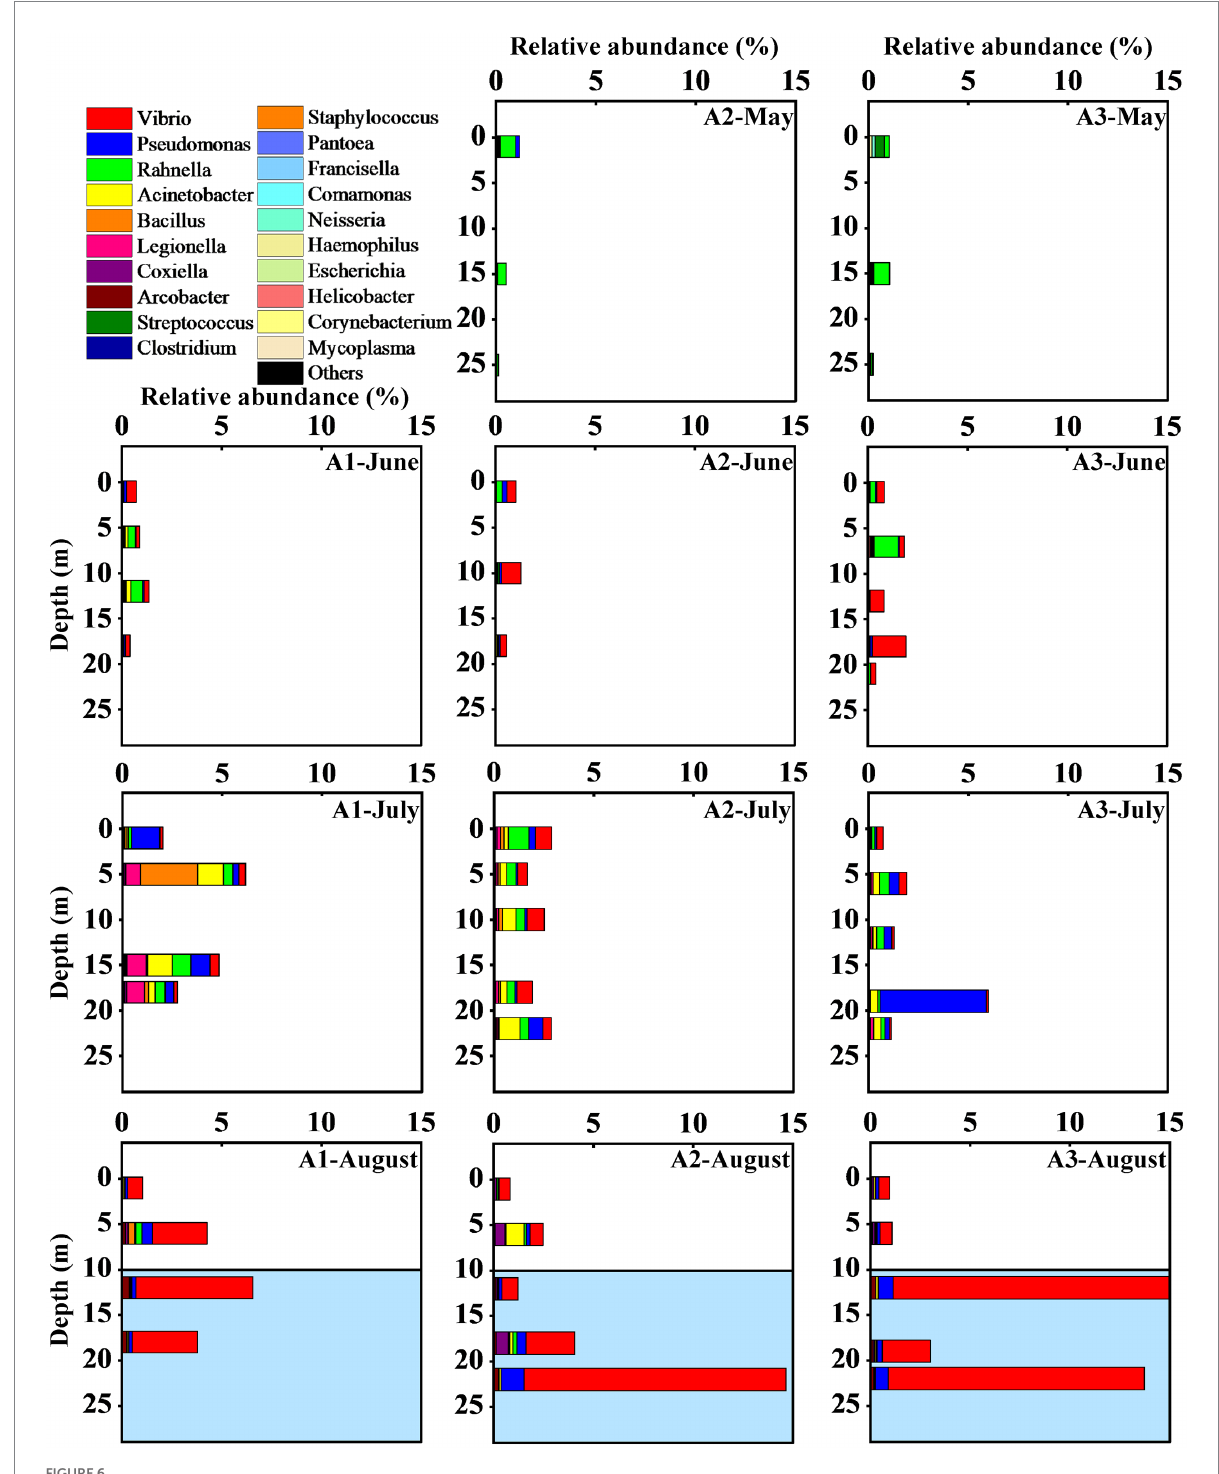
FIGURE 6 Vertical distribution of the relative abundance of pathogenic bacterial communities at the genus level from May to August.” Others” refers to OTUs with very low abundance (<0.001%). The hypoxia zone formed in August (The area marked in